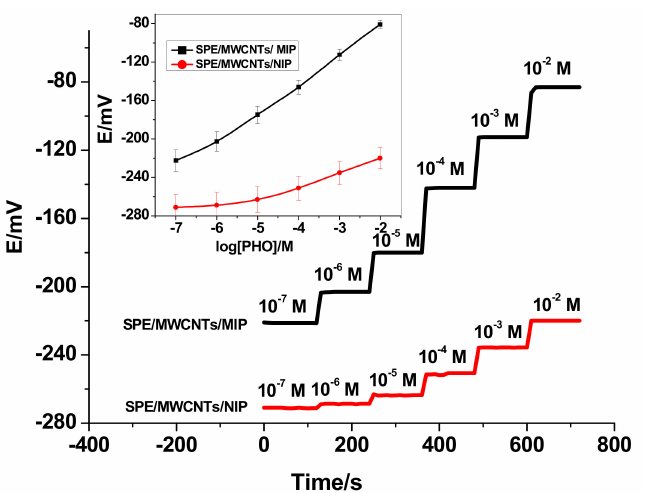
Figure 3. Time-dependent potential responses (inset: the calibration curve for the integrated screen- printed sensors).